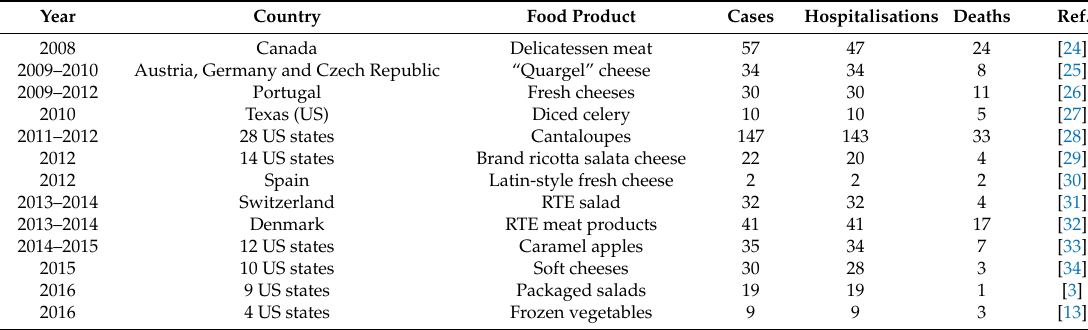
Table 1. Main outbreaks of foodborne listeriosis since